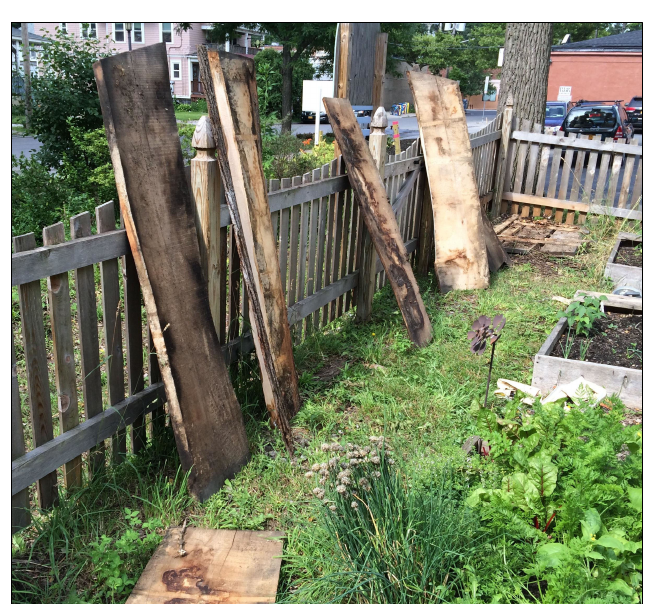
Figure 1. Maple planks leaning against the fence of the community